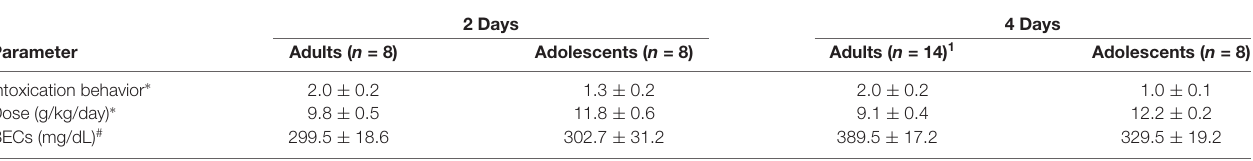
TABLE 1 | Animal model parameters.